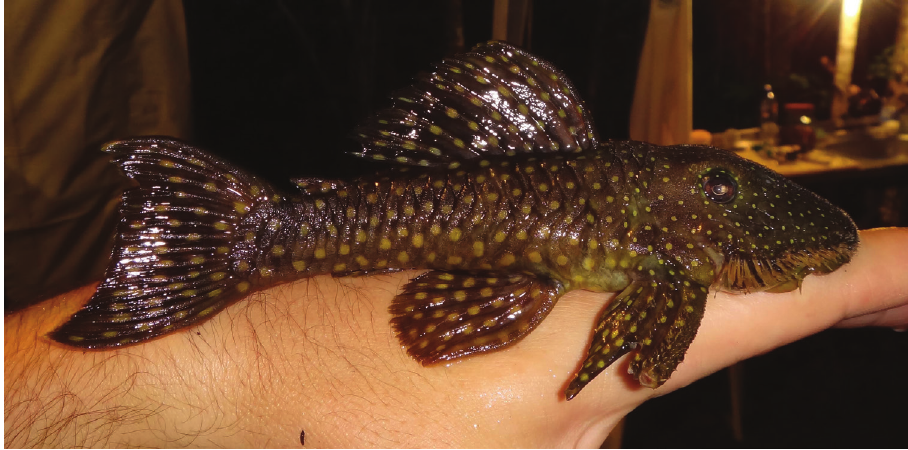
Figure 3. Pseudancistrus zawadzkii , live specimen, LBP 15045, paratype, female, 128.7 mm SL, Tapajós river, Pará State,